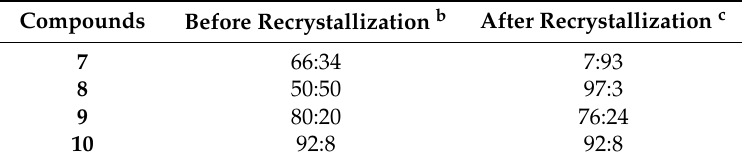
Table 1. The diastereoselectivities a observed before and after recrystallization. Compounds Before Recrystallization b After Recrystallization c 7